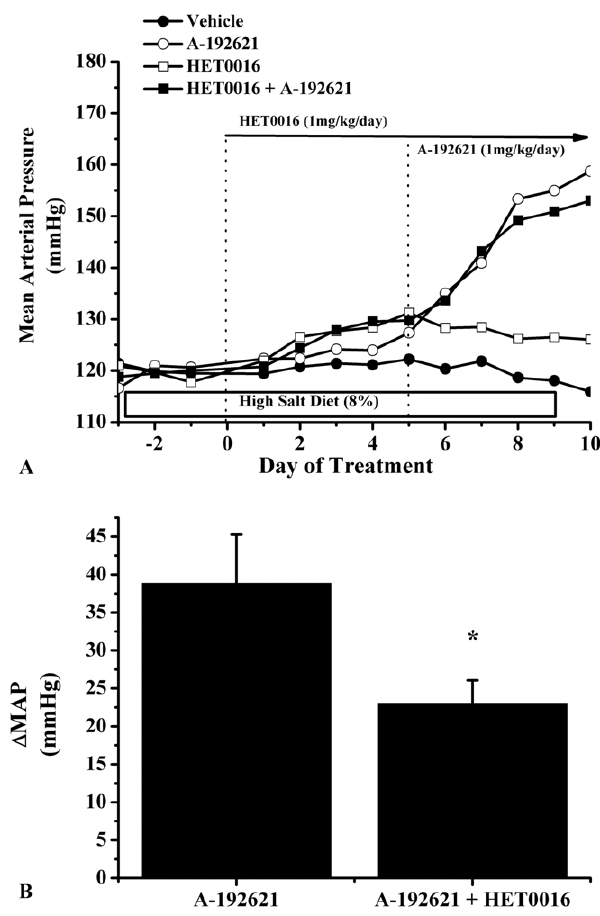
Figure 4. Mean arterial pressure in rats with intramedullary blockade of ET-B receptors in the presence and absence of a 20-HETE inhibitor. A ) This figure illustrates the changes in blood pressure in response to chronic intramedullary infusion of the ET-B antagonist, A-192621, the 20-HETE inhibitor, HET0016, and rats pretreated with HET0016, and then administered A-192621. B ) Illustrates that the increase in blood pressure in response to intramedullary blockade of ET-B receptors is blunted when the rats are pretreated with a 20-HETE inhibitor. *indicates that p , 0.05 vs. A- 192621 treated